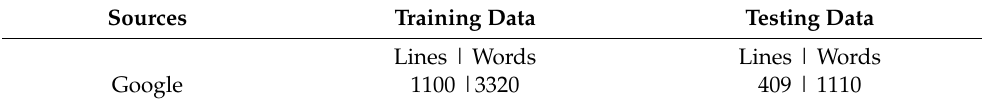
Table 3. Statistical detail of curated dataset. Table 2. Statistical detail of ALIF dataset.